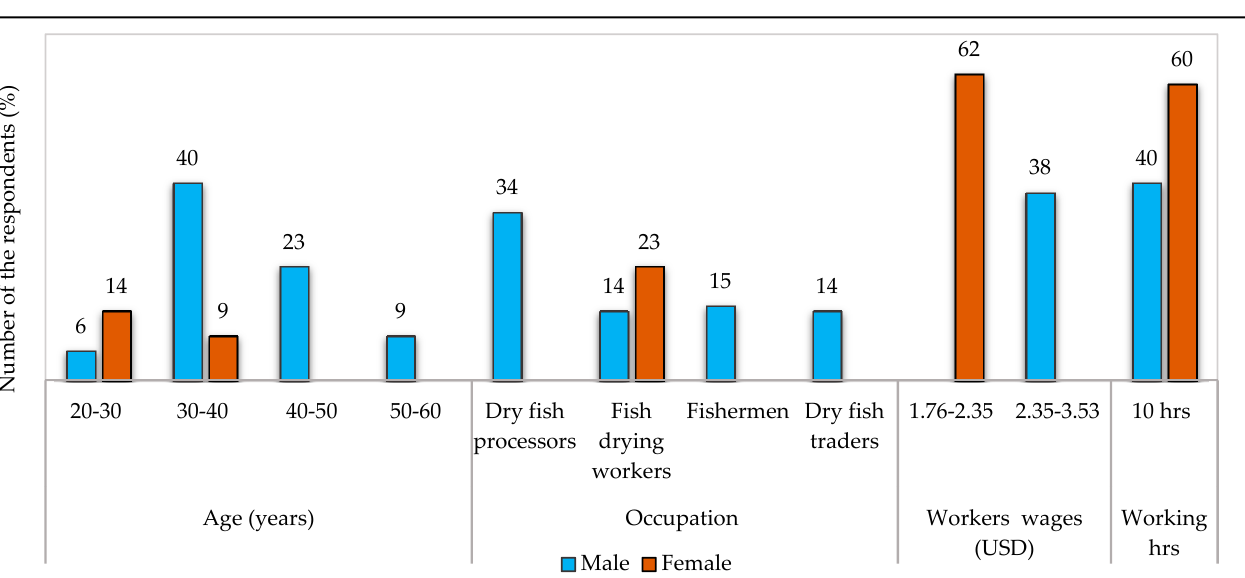
Figure 3. Gender participation profile of the fish drying community living in Nazirertek. Most of the child workers in Nazirertek belonged to the age group 5–15 years (5% male, 6% female), while male children earned USD 2.02–2.52 day − 1 (3%) to USD 3.54–4.12 day − 1 (4%) and female earned (2%) USD 2.36–2.95 day − 1 (Figure 3). Figure 4 shows that no children were engaged in drying fish in Chitapara. In contrast, male workers received maximum wages (62%) ranging from USD 2.35–3.53 day − 1 , and the minimum wages were received by female workers (38%) ranging from USD 1.76–2.35 day − 1 .